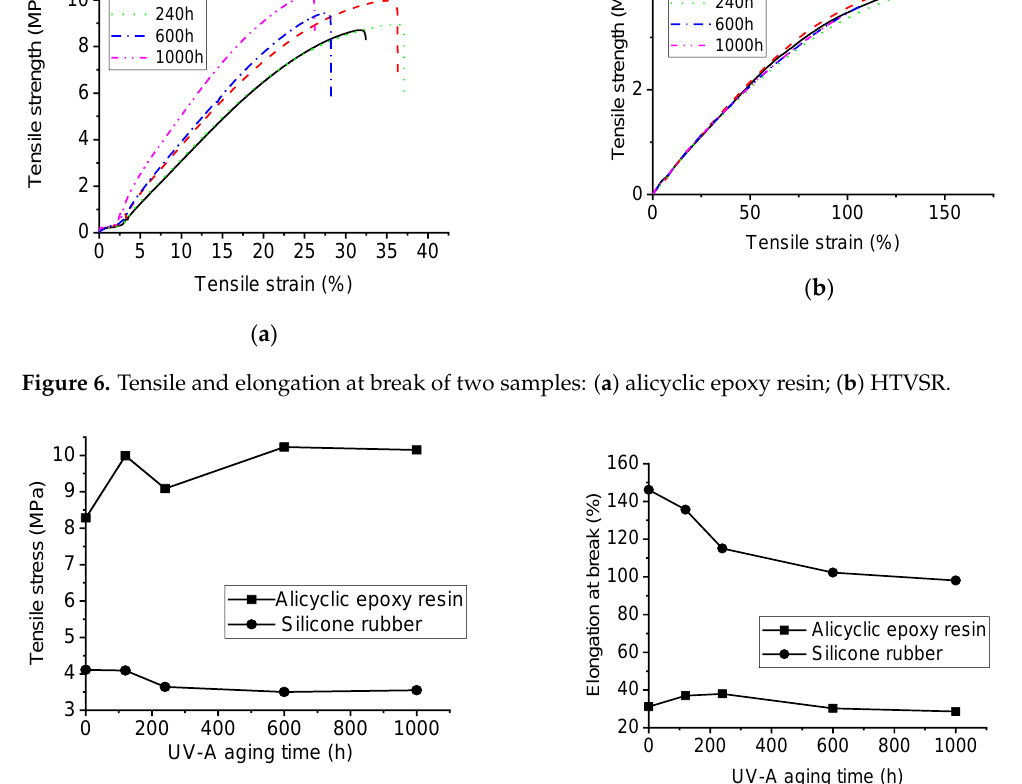
Figure 7. Comparison of mechanical properties of two samples at different UV-A aging time: (a) tensile stress; (b) elongation at break.